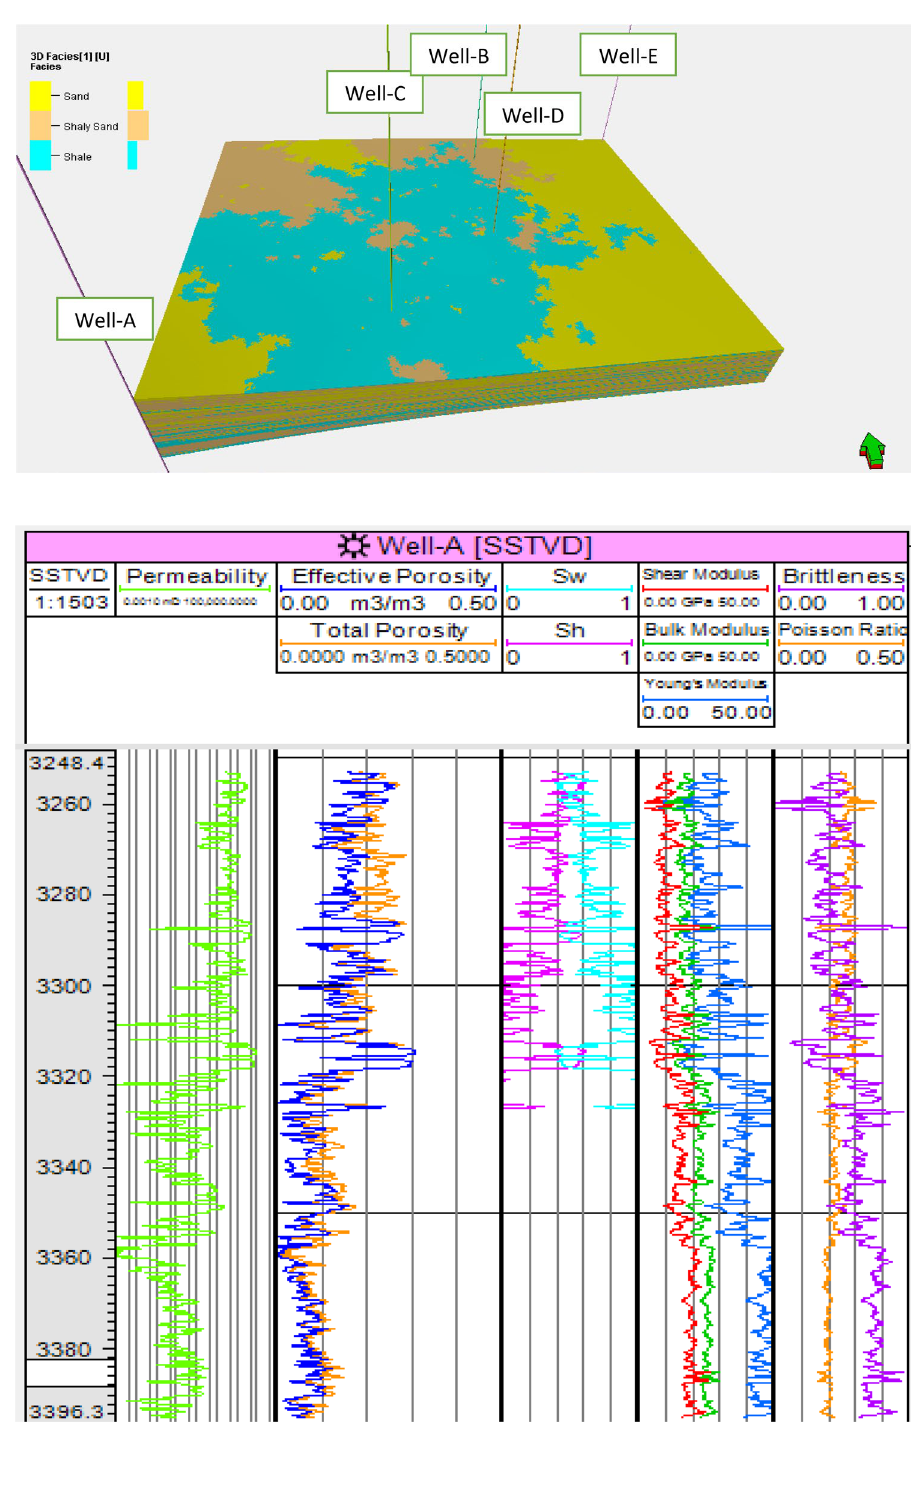
Fig. 11 3D facies model of the studied reservoir